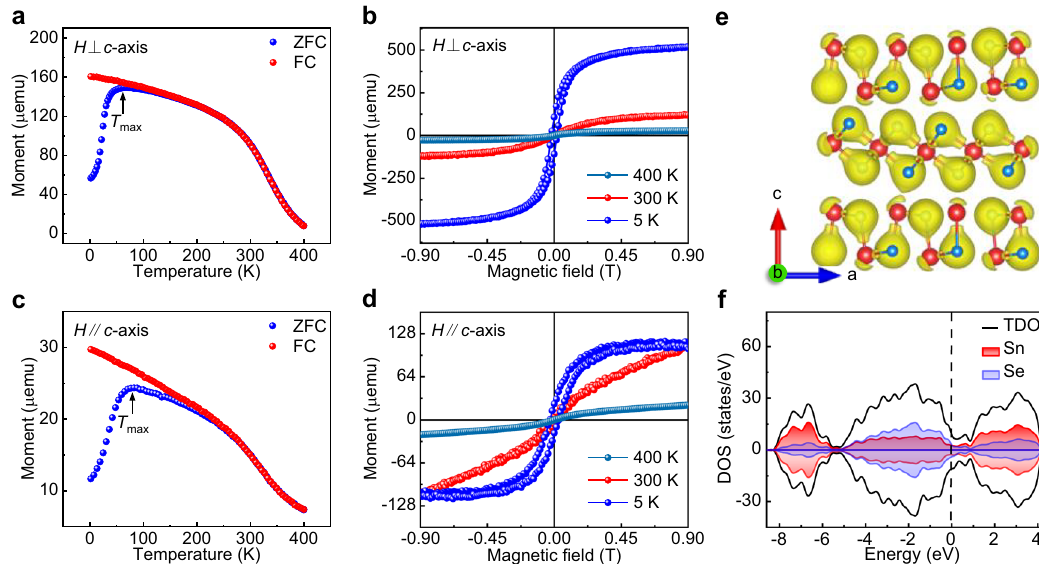
Fig.4|FerrimagnetismofPVD-synthesized2Dp-dopedSnSe.a , c Temperature- dependent magnetic moment of 2D p-doped SnSe nanosheets with a vertical and parallel magnetic fi eld at 100Oe. T max is de fi ned as the temperature at which the maximum magnetic moment is obtained during the ZFC process. b , d Magnetic hysteresisloopsof2Dp-dopedSnSeat~5,~300,and~400Kwiththemagnetic fi eld